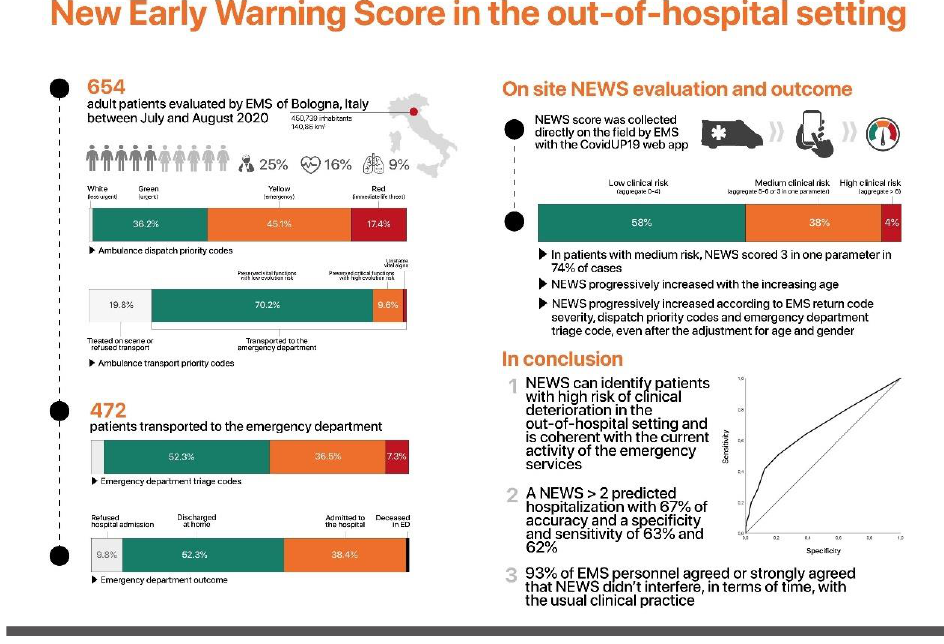
Figure 1. Infographics of the descriptive statistics.